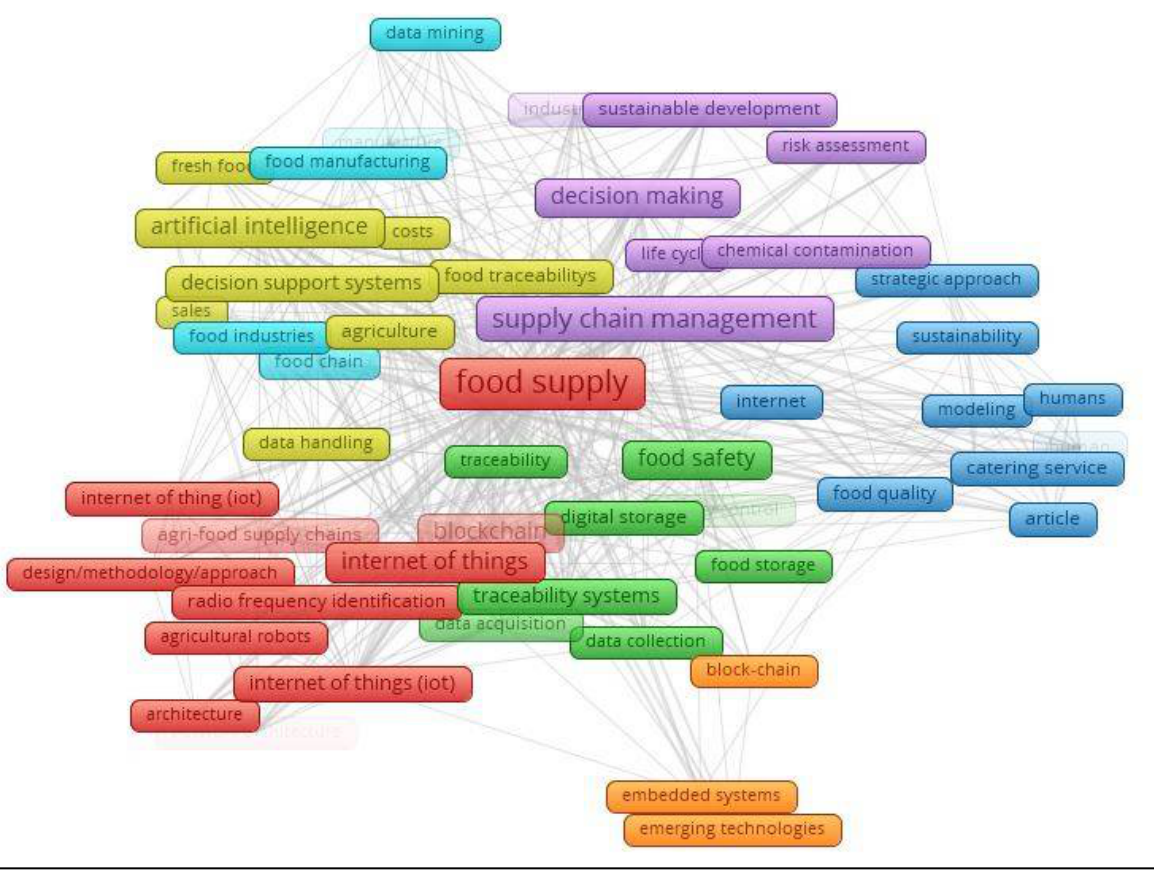
Figure 6. Indexed keyword coupling. Table 5. Research Link Strength and Citations between